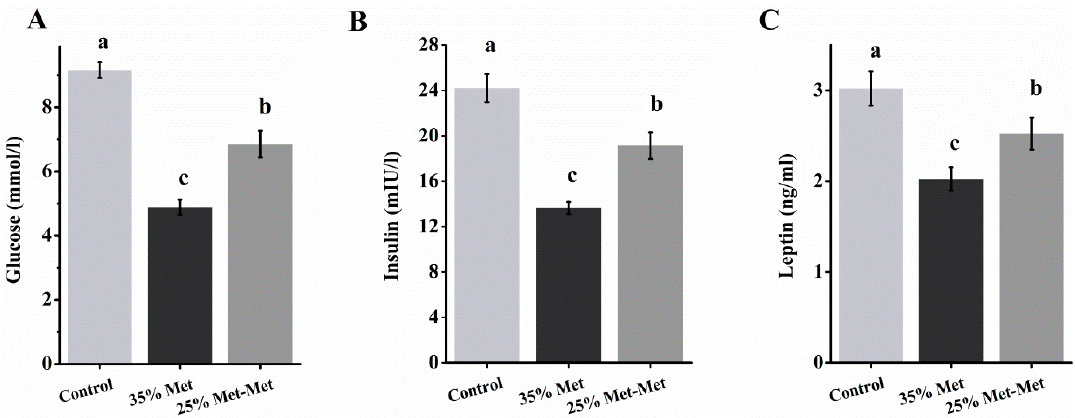
Figure 5. Maternal plasma concentrations of glucose ( A ), insulin ( B ), and leptin ( C ) at day 17 with different sources of methionine (Met) supplementation. In the control group, pregnant mice were fed a diet containing free Met. In the 35% Met group, pregnant mice were fed a Met-deficient diet with intraperitoneally injection of 35% of the Met contained in the control diet. The 25% Met-Met group was treated as described for the 35% Met group, except that 25% of the injected Met was replaced with methionyl-methionine (Met-Met). Data are expressed as the mean ± SEM, n = 8. The different letters indicate significant differences, p < 0.05.